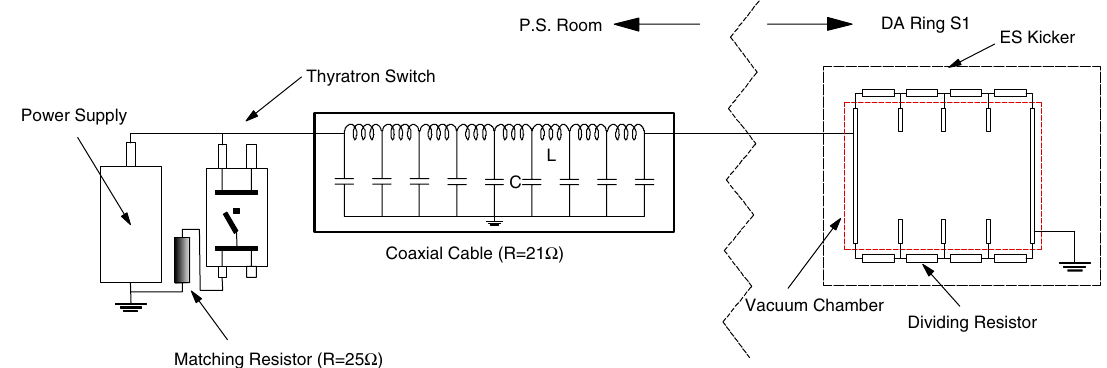
FIG. 3. Schematic of the excitation circuit of the ES-Kicker.